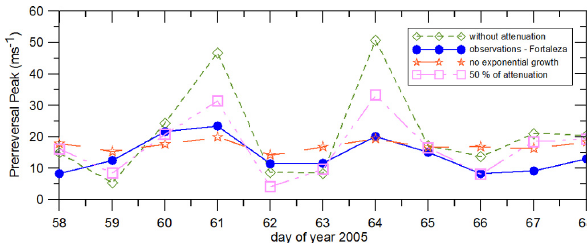
Fig. 6. Maximum vertical drift velocity calculated during the evening pre-reversal enhancement hours. The blue line represents the observational results. The green, pink and orange lines represent the results obtained by the model considering propagation with ex- ponential growth of the wave amplitude, 50% attenuation, 75% at- tenuation and no exponential growth of the amplitude,